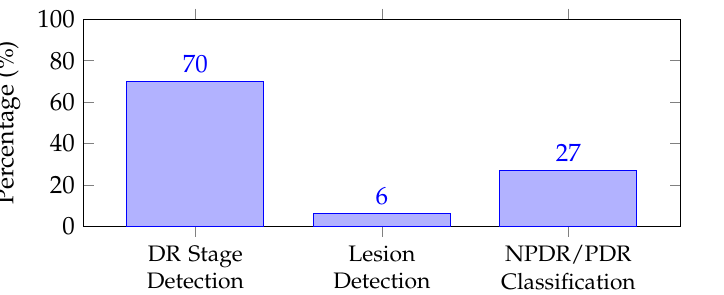
Figure 2. Percentage of studies with a focus on different aspects of DR, highlighting the lower percentage dedicated to lesion detection.